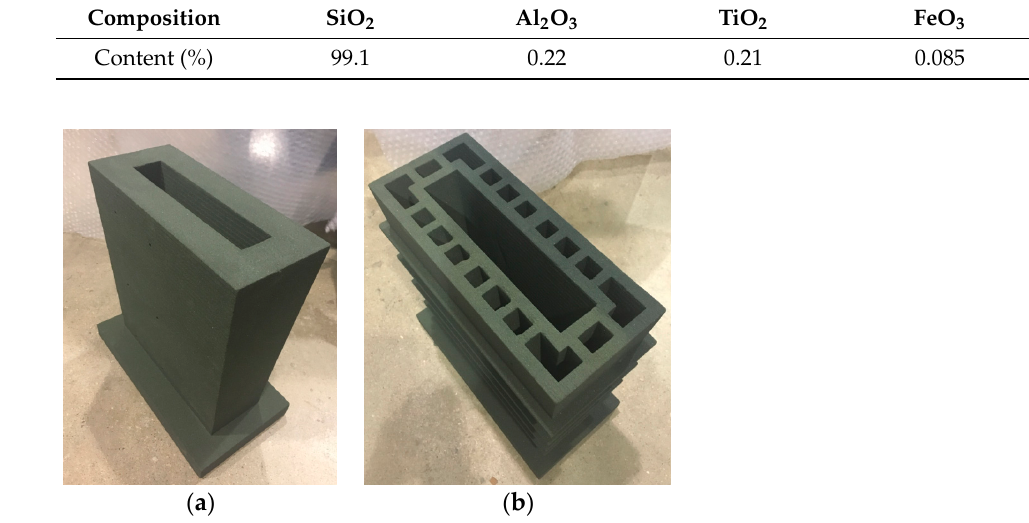
Table 1. Composition of the sand used for 3D printing.